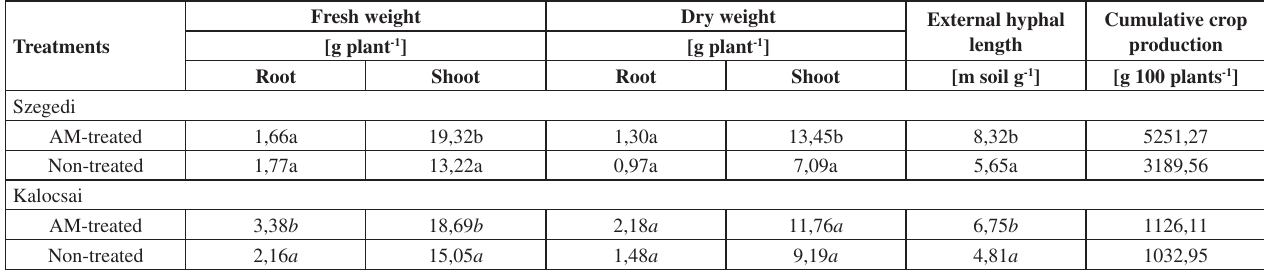
Table 1. Effects of commercial mycorrhizal inoculants on growth, external hyphal length of AMF and cumulative crop production during cultivation of spice pepper cv. Szegedi and cv.Kalocsai Treatments